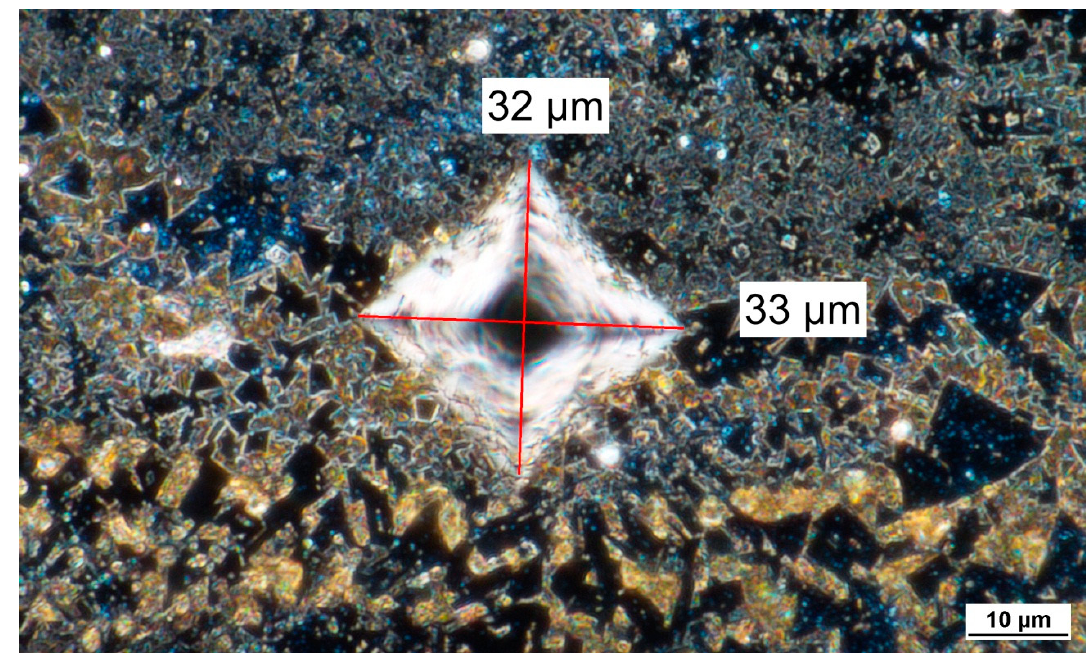
Figure 7. Micrograph of a Vickers hardness test indentation.